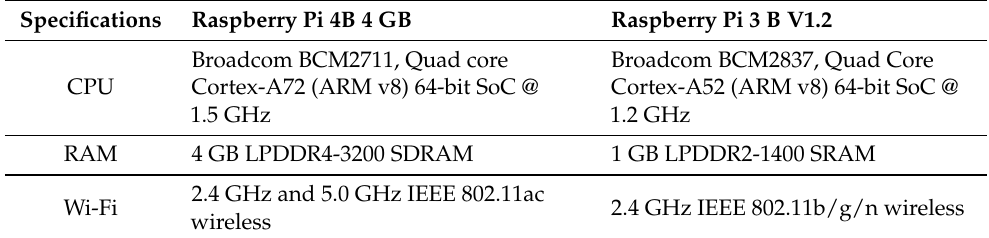
Table 1. Technical specifications of the Raspberry Pis implemented in our testbed.